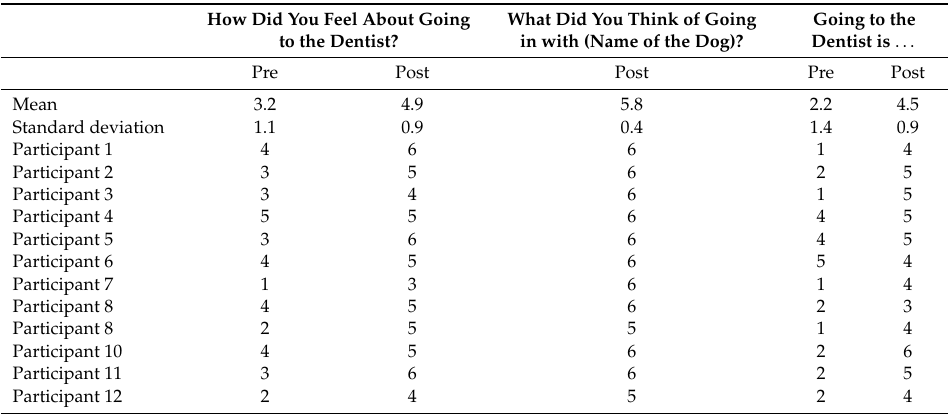
Table 2. Participant’s perceptions before and after the assisted dental intervention with dogs.